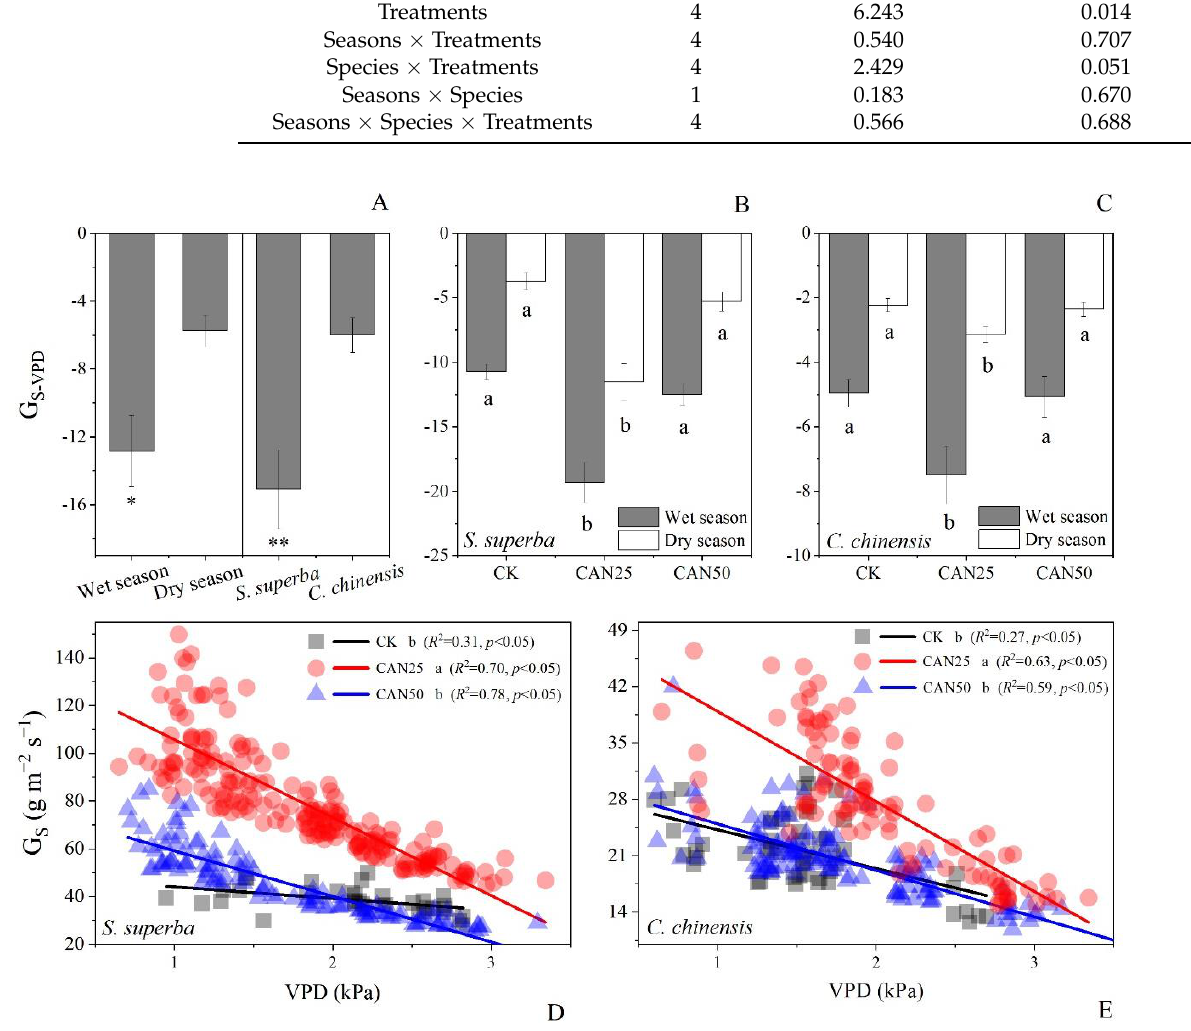
Figure 6. The mean values ( A – C ) and the linear fitting ( D , E ) of the slopes of VPD to G S (G S-VPD ) under different nitrogen addition treatments (CK, CAN25, CAN50), in the dry and wet seasons, S. superba and C. chinensis , different letters indicate significant differences at p < 0.05; * indicate significant differences at p < 0.05; ** indicate significant differences at p <